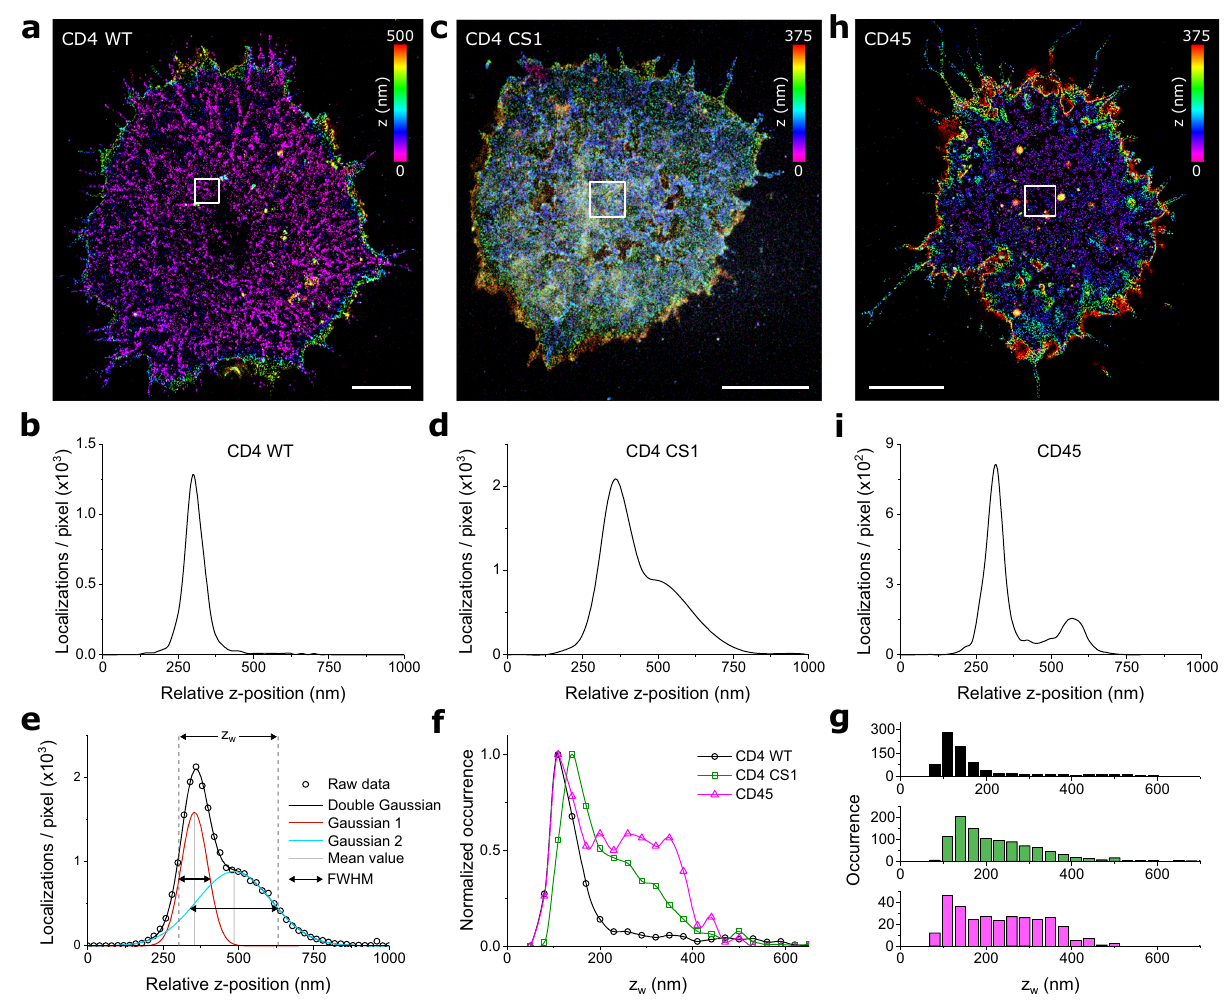
Fig. 5 CD4 clusters represent the receptor accumulation at the tips of membrane protrusions. a Representative three-dimensional dTRABI image of CD4 WT at the surface of Jurkat cell immobilized on a glycine-coated coverslip. b The axial distribution of CD4 WT localizations of the 4 μ m² region of interest (ROI) of the cell in a . c Representative 3D dTRABI image of non-palmitoylatable CD4 CS1 mutant at the surface of Jurkat cell immobilized on a glycine- coated coverslip. d The axial distribution of CD4 CS1 localizations of the 4 μ m² ROI of the cell in c . e – g Quantitative analysis of the receptor axial ( z -axis) distribution on the surface of T cells. Receptors were analyzed by using a bi-Gaussian fi t to the axial distribution of localizations for each ROI as in b , d and i (see Supplementary Fig. S11 for more examples and Supplementary Data for the details) and the FWHM range of the two Gaussian functions represent the z -distribution width ( z w ) as depicted in e . Black circles in e represent the axial distribution of receptor localizations for a selected ROI, black line the bi- Gaussian fi t, which is the sum of two Gaussians as depicted in red and blue, dashed lines in gray depict z w and lines in light gray depict mean values of the Gaussian distributions. The graphs in f and g represent histograms of z w obtained from 21 CD4 WT cells with 846 ROIs (black), 18 CD4 CS1 cells with 1044 ROIs (green) and 13 CD45 WT cells with 305 ROIs (magenta). The histograms in f and g show relative and absolute occurrence, respectively. Data points in b , d , f and i were spline interpolated to guide the eye. h Representative 3D dTRABI image of CD45 at the surface of Jurkat cell immobilized on a glycine-coated coverslip. Color-bars in the upper right corner of a , c and h indicate the axial position of the localizations in the image. i The axial distribution of CD45 localizations of the 4 μ m² ROI of the cell in h . CD4 variants and CD45 were stained with directly labeled primary antibody as in Figs. 3 and 4, respectively. Scale bars in a and c and h , 5 μ